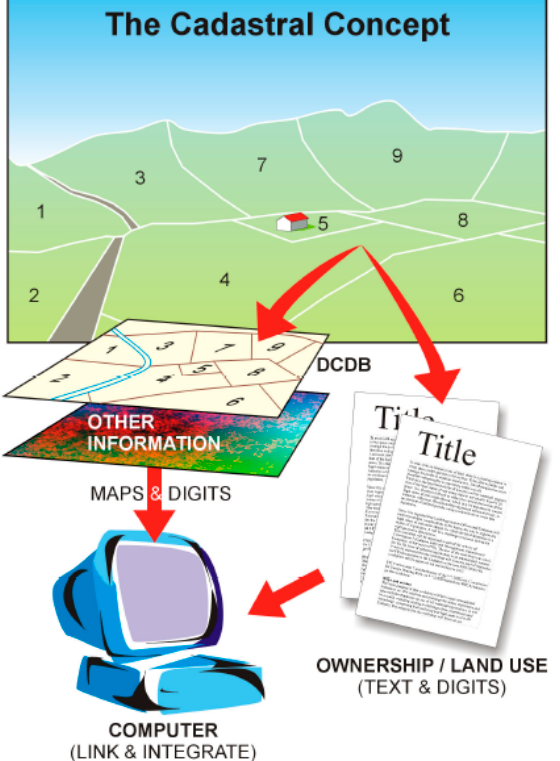
Figure 2. The FIG Statement on the Cadaster [53].